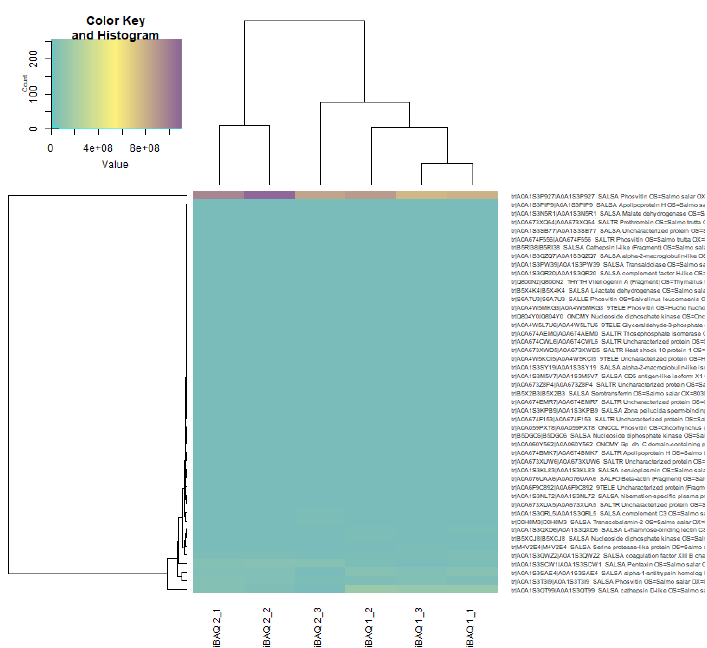
Figure 7. Heatmap of raw LFQ data in proteome of Atlantic salmon eggs ( Salmo salar L.) for control and experimental groups. Note: iBAQ1_X is a control group, iBAQ2_X is an experimental group, where “X” is a serial number. Quantities are presented in gradient format (legend top left). The upper dendrogram is the hierarchical clustering for the experimental group, the left dendrogram is for the identified proteins.